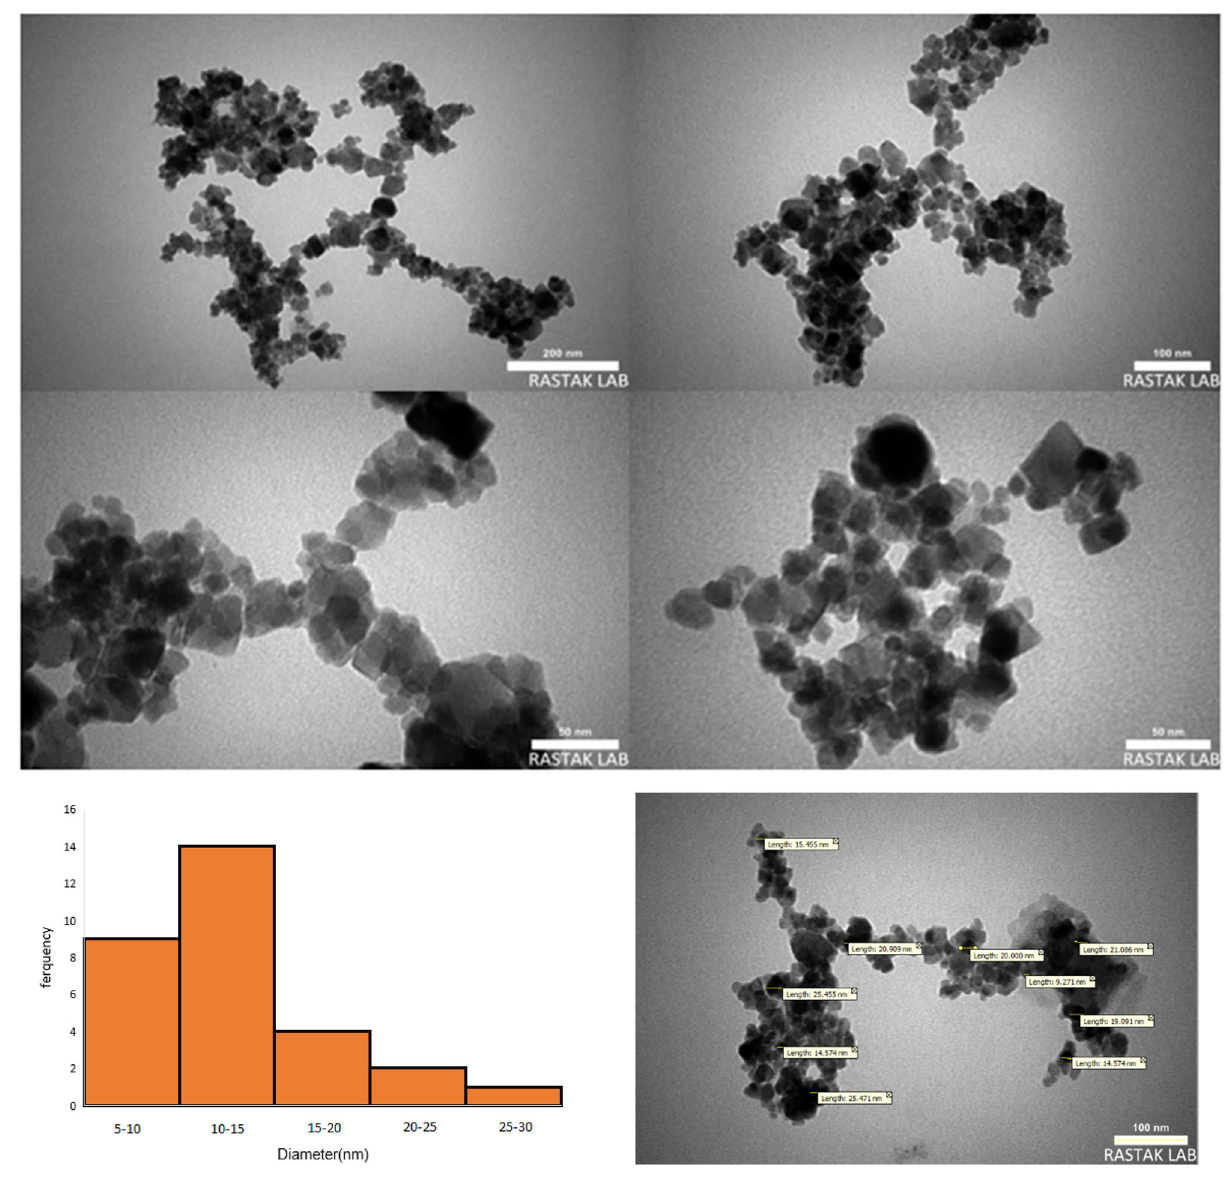
Figure 9. TEM image of Fe 3 O 4